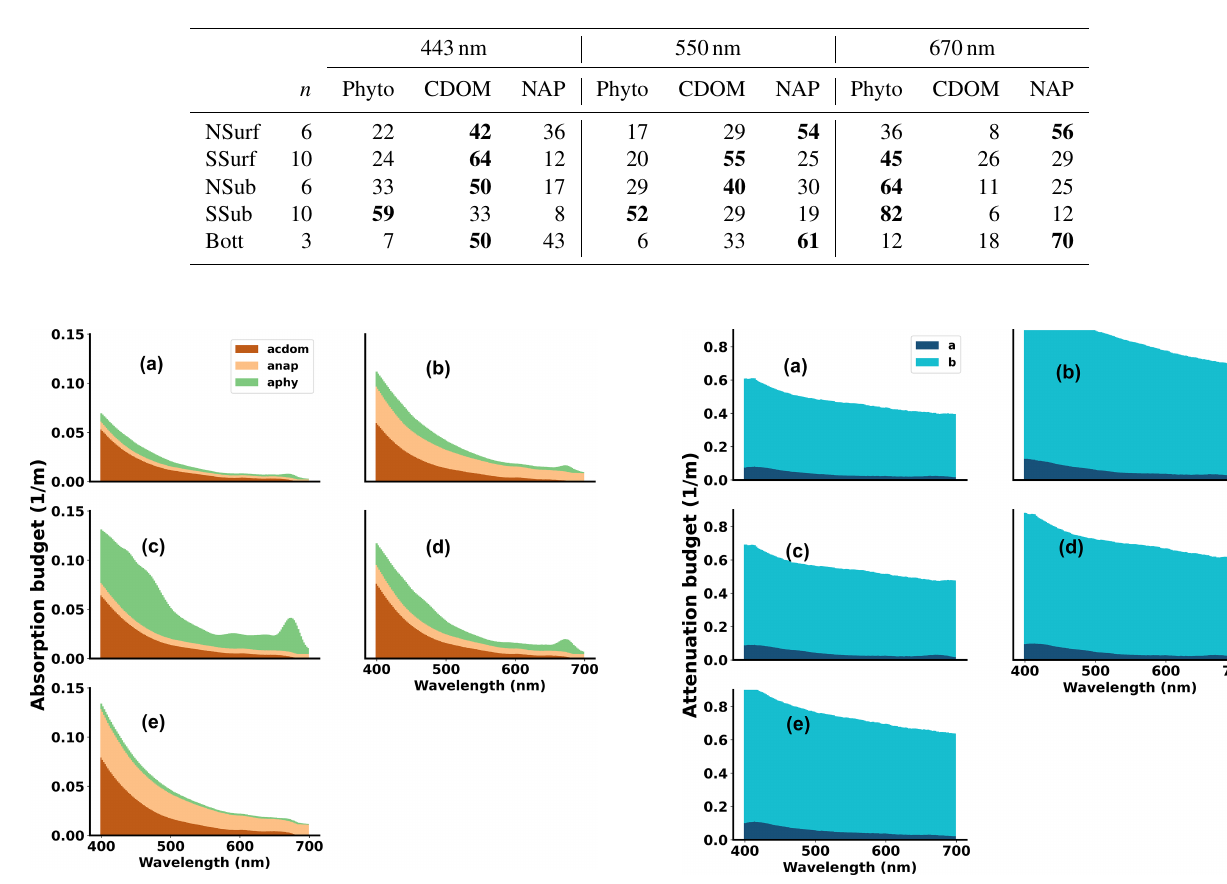
Table 2. Relative contributions (in %) of the phytoplankton, CDOM, and non-algal particles (NAPs) to the absorption budgets at 443, 550, and 670nm for the five cases corresponding to northern surface (NSurf), southern surface (SSurf), northern subsurface (NSub), southern subsurface (SSub), and dense bottom water (Bott). Bold numbers indicate the constituent dominating the absorption for a given case and wavelength.